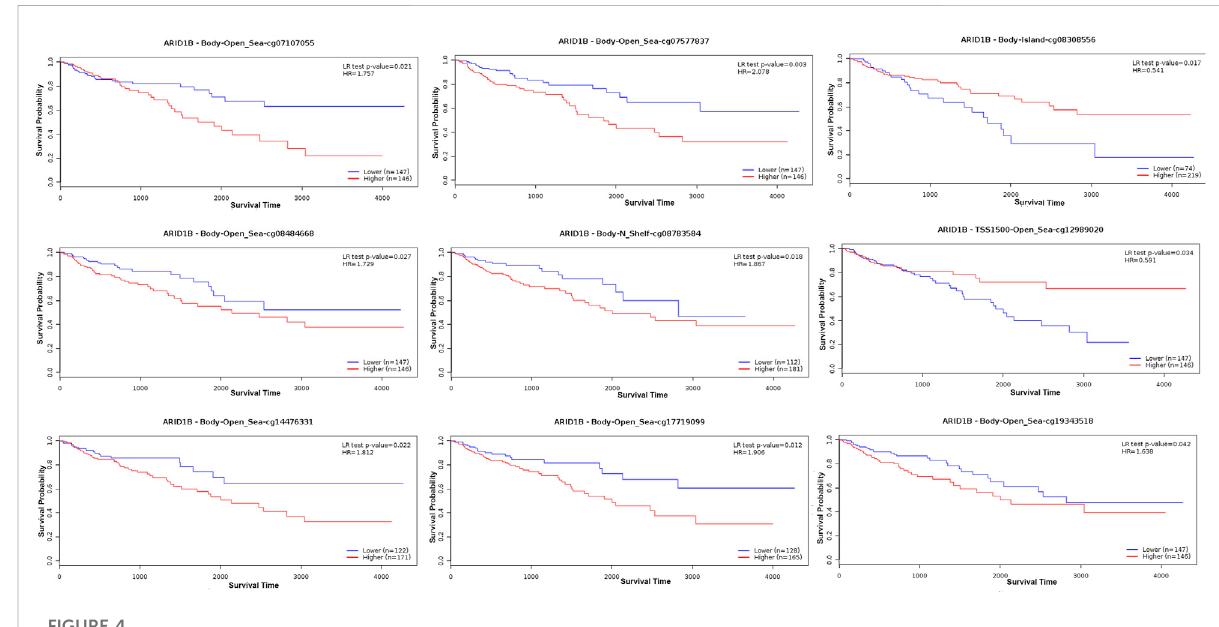
FIGURE 4 ARID1B hypermethylation impacts the prognosis of COAD patients.